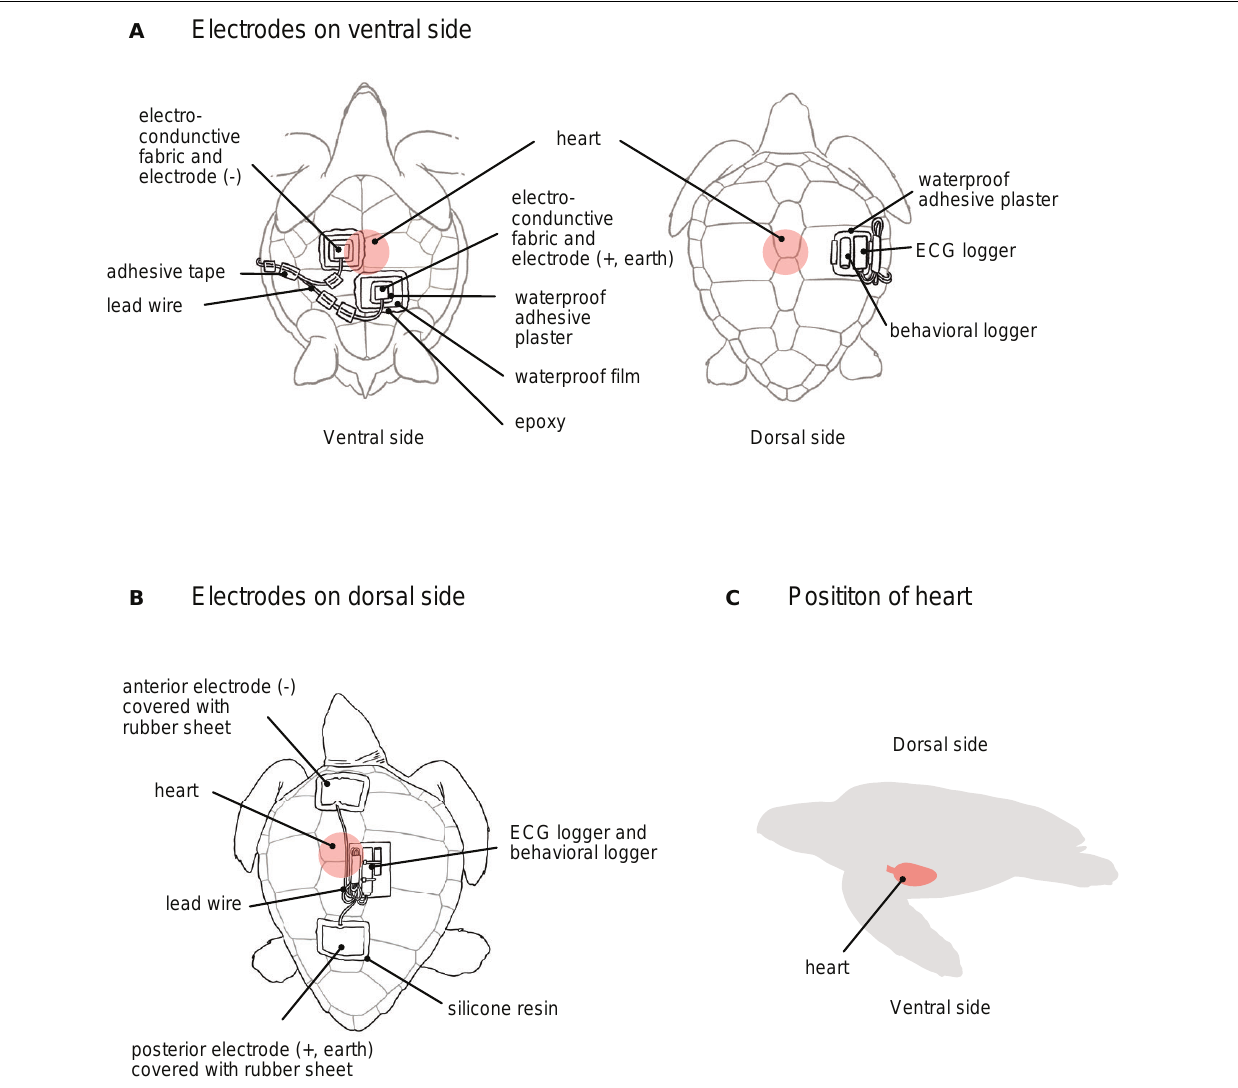
ECGs were measured simultaneously to evaluate the effect of the attachment position ( Figures 1A,B